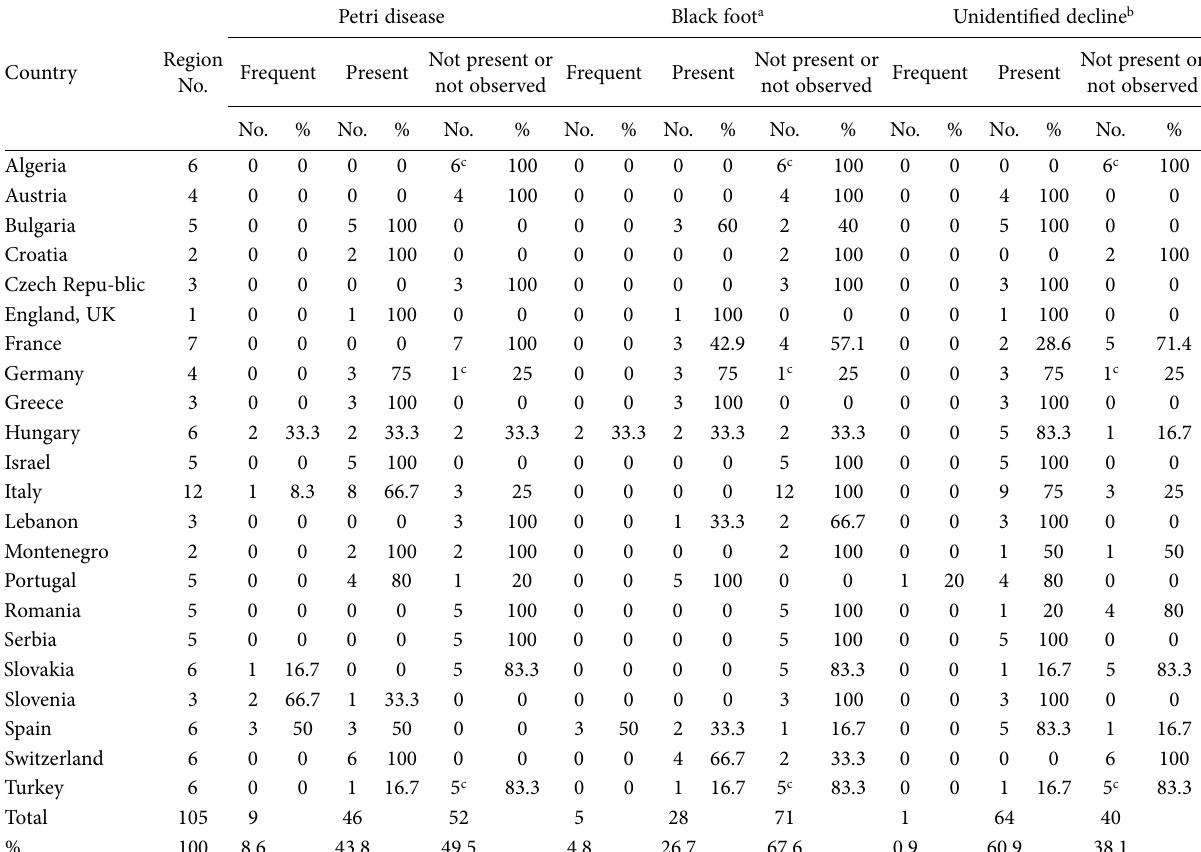
Table 5. Reported levels of occurrence of GTD on young vines in surveyed European and Mediterranean countries.